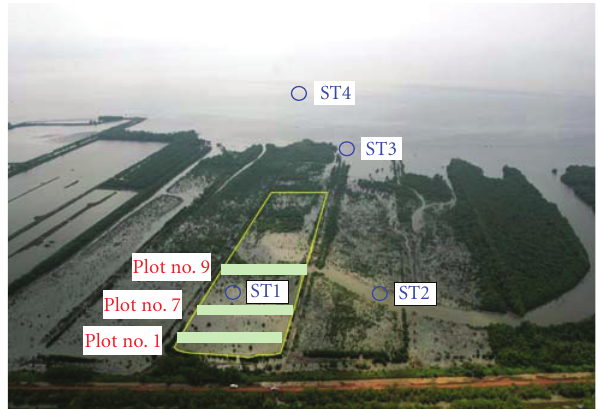
Figure 4: View of the study site taken by remote-controlled helicopter from 500m above sea level. The enclosed area shows the location of the study site (approximately 6ha). Blue circles show the stations where the samples were taken for measurements of water, sediment, and biological